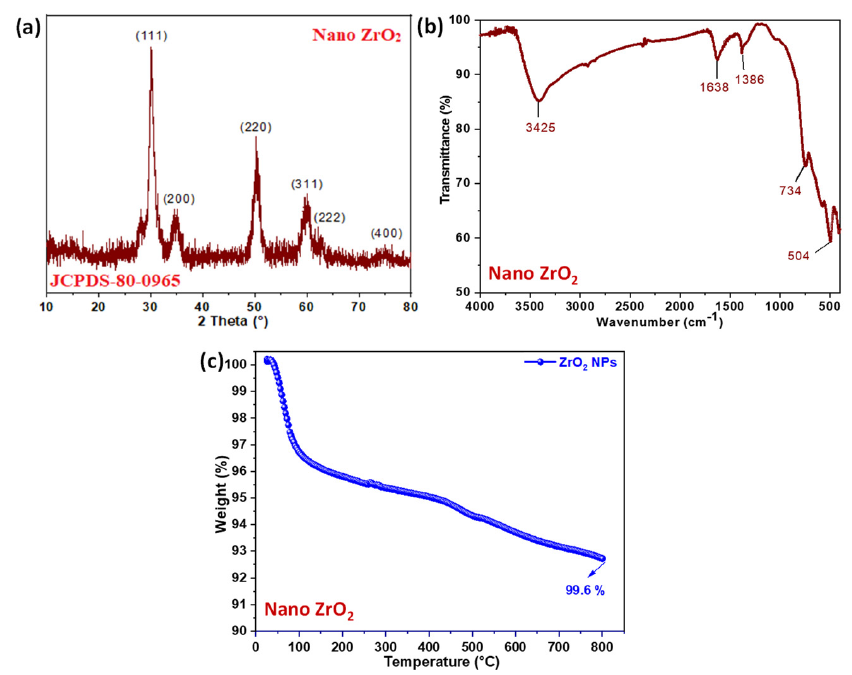
Figure 2. ( a ) XRD, ( b ) FT-IR, and ( c ) TGA of nano-ZrO 2 .